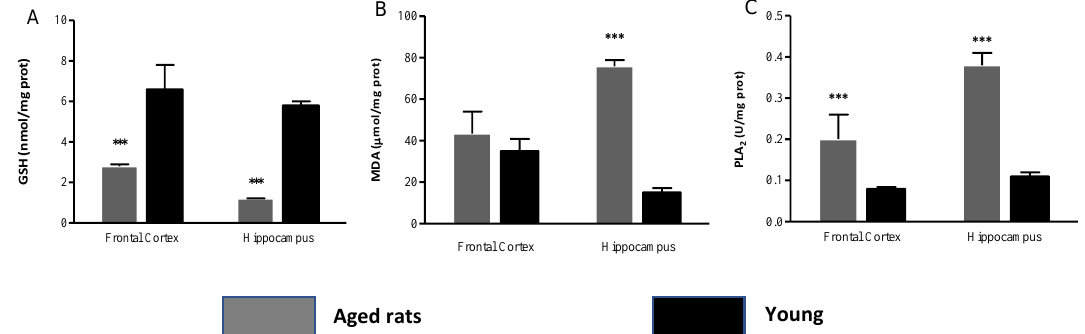
Figure 3. Effect of aging on oxidative metabolism indicators in the examined brain areas. ( A ) Glutathione (GSH), ( B ) Malondialdehyde (MDA), ( C ) Phospholipase A2 (PLA2). *** Corresponds to significant differences between experimental groups ( p < 0.001). Table 2. Data (mean ± SD mean) corresponding to biochemical indicators in examined brain areas between experimental